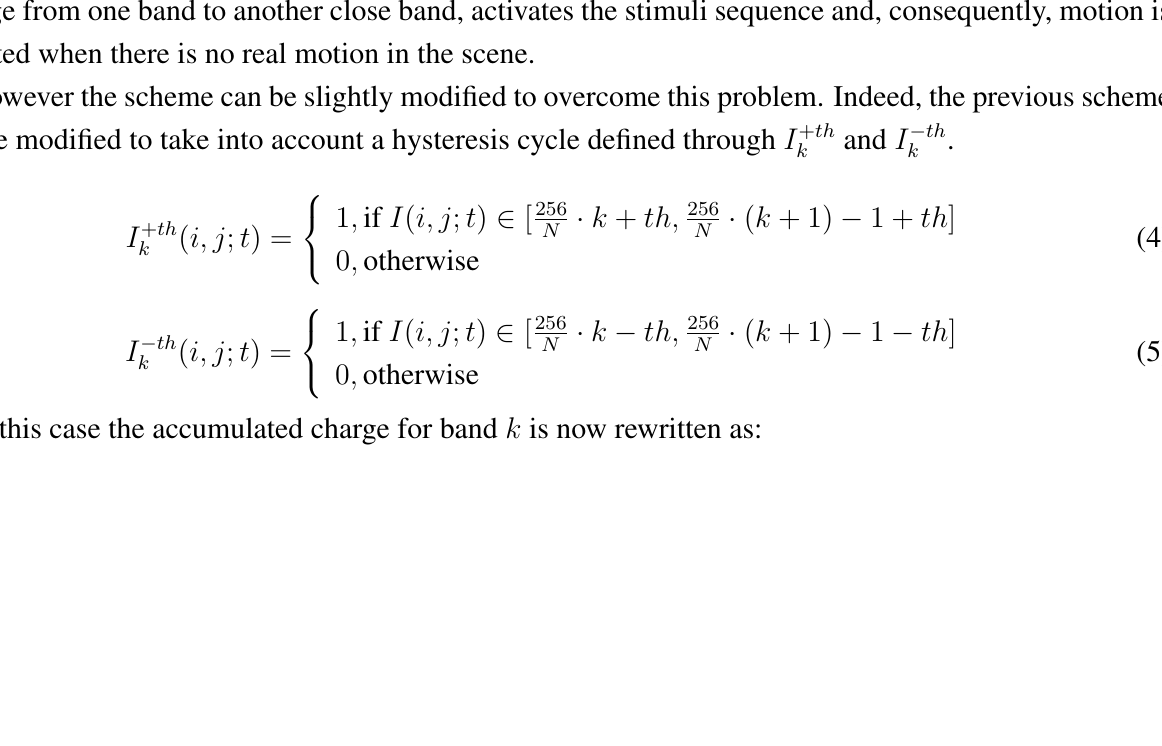
( i; j ; t − ∆ t ) and I k